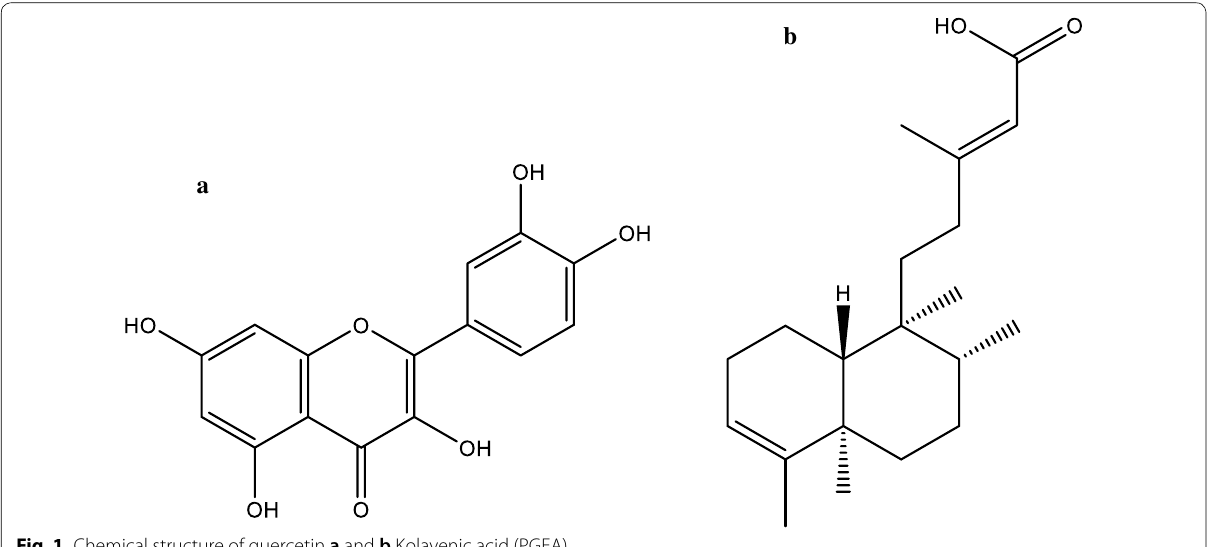
Fig. 1 Chemical structure of quercetin a and b Kolavenic acid